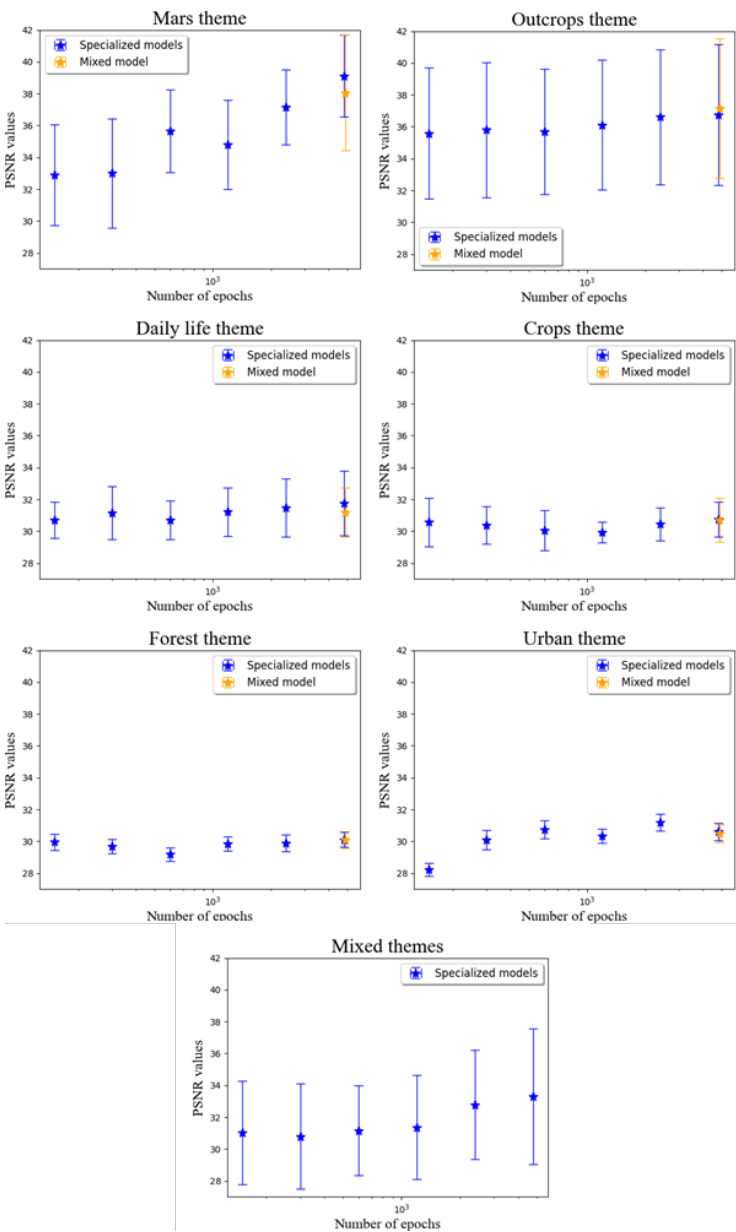
Figure 8. Peak signal-to-noise ratios (PSNRs), with their associated standard deviations, for the different themes. For the highest number of epochs, the “mixed” model also tested whether increasing the variability in the samples was relevant.